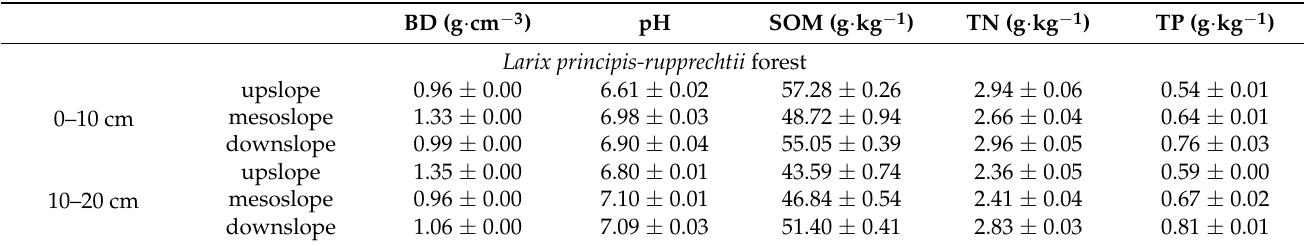
Table 2. Quality parameters of soil in the sampled